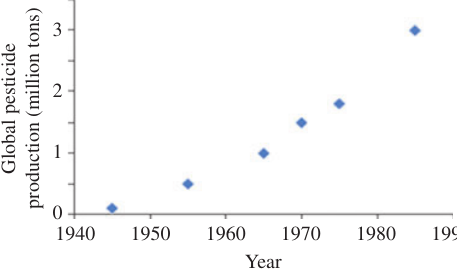
Figure 1 Global pesticide production ( Tilman et al. 2001